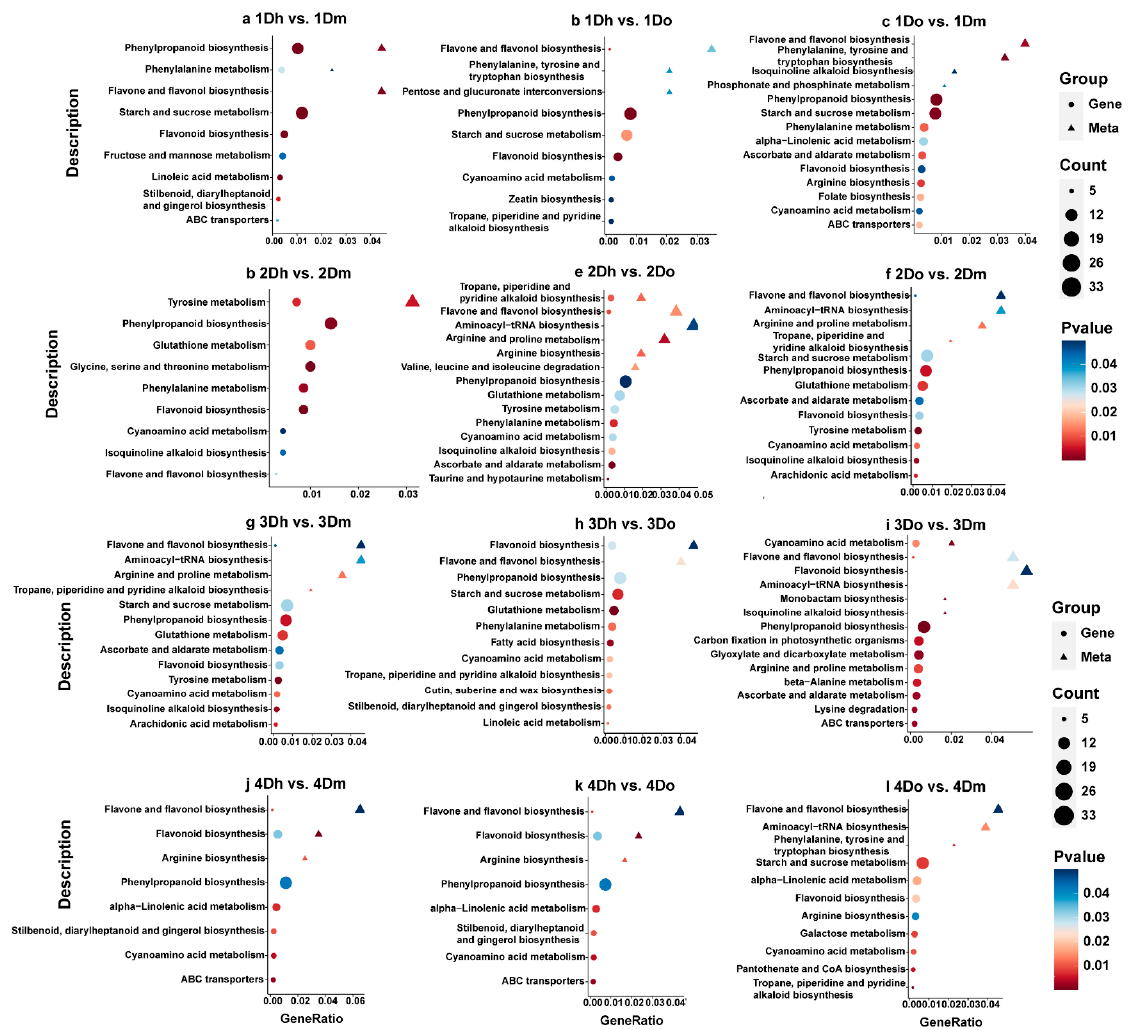
Figure 6. KEGG enrichment analysis of DAMs and DEGs. The color of the points indicates the de- gree of enrichment and the size of the points indicates the number of enriched DAMs or DEGs. The circle represents DEGs and the triangle represents